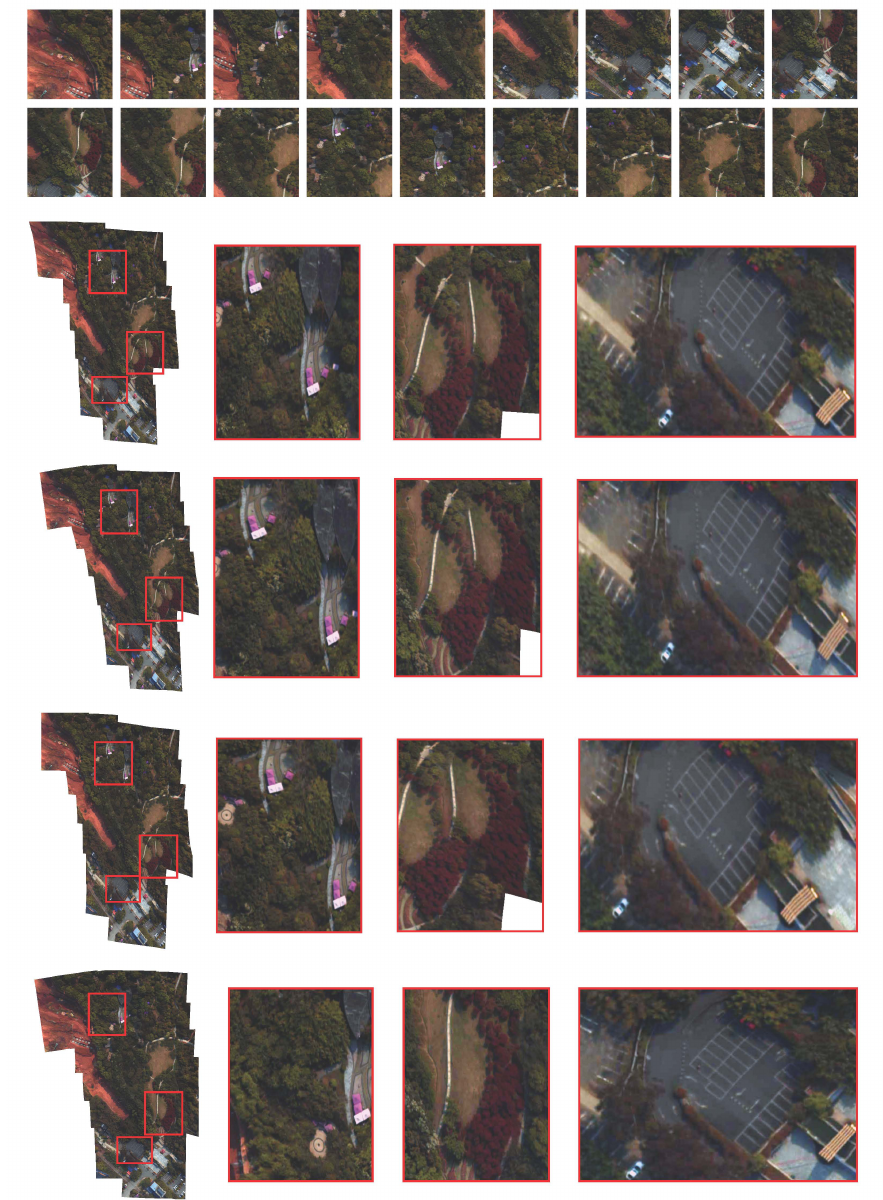
Figure 8. Comparison of the stitching results among ANAP [25], NISwGSP [26], ELA [27], and the proposed method (from ( top ) to ( bottom )). At the top are the 18 original images to be